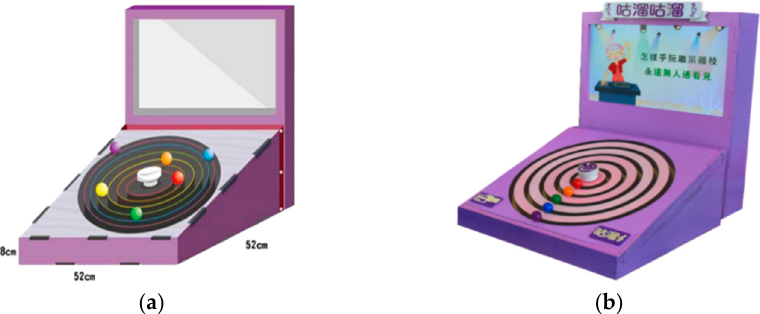
Figure 3. The proposed tangible interactive device. ( a ) An illustration of the design of the proposed interactive device. ( b ) A real construction of the device.